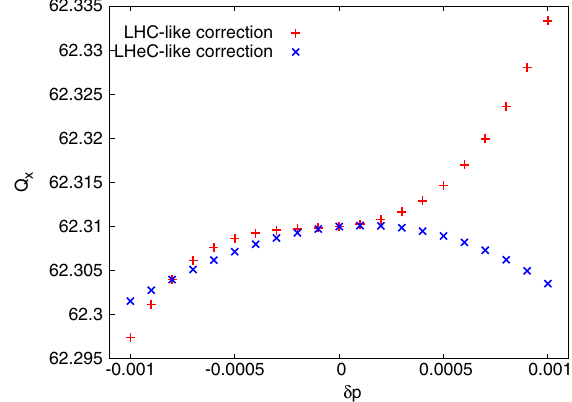
FIG. 8. Montague W x and W y functions along beam 2 after the LHeC-like chromatic correction (the machine starts in IP8).